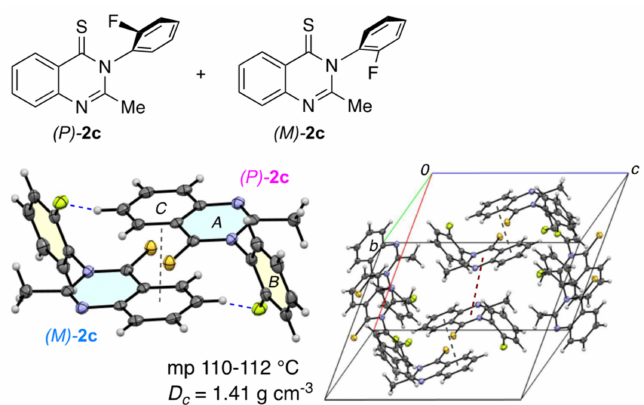
Figure 7. Parts of the packing structure of racemic 2c at 100 K with 50% probability thermal